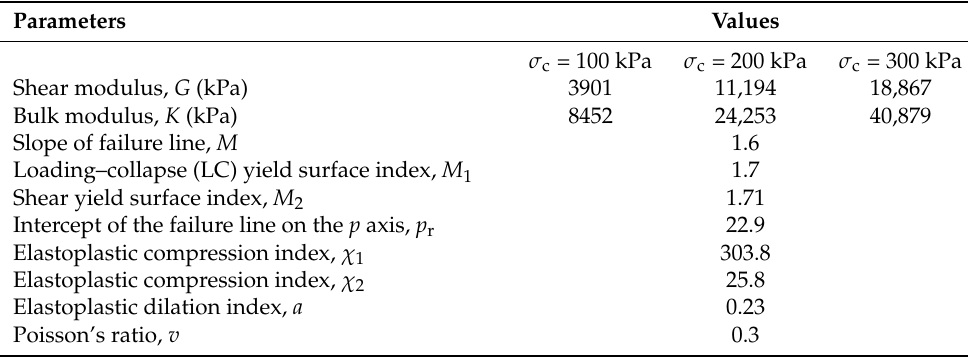
Table 2. Parameter values for the proposed elastoplastic model with N FT = 5 used in [36].